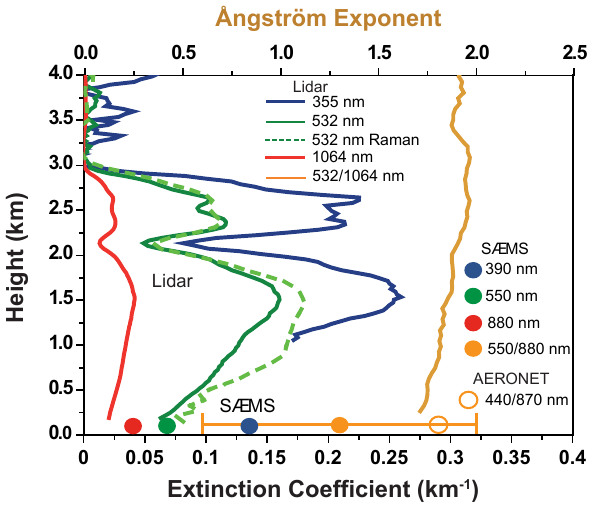
Fig. 7. Vertical profiles of the particle extinction coefficient at 355, 532, and 1064nm wavelength and corresponding Ångström ex- ponent (orange, 532–1064nm spectral range) derived from cloud- screened lidar observations on 3 May 2009, 11:00–13:00UTC. The circles at ground level are the corresponding SÆMS measurements of the extinction coefficient at 390nm (blue circle), 550nm (green circle), and 880nm (red circle) and the Ångström exponent com- puted from the extinction values from 550 to 880nm (orange circle with uncertainty bar), and from AERONET data (open orange cir- cle, 440–870nm). The elastic backscatter signals are used in the cal- culation of the extinction coefficient profiles, except for the dashed green line, which is computed from the height profile of the ratio of the elastic (532nm) backscatter to nitrogen Raman signal profile, and is almost not overlap-affected.